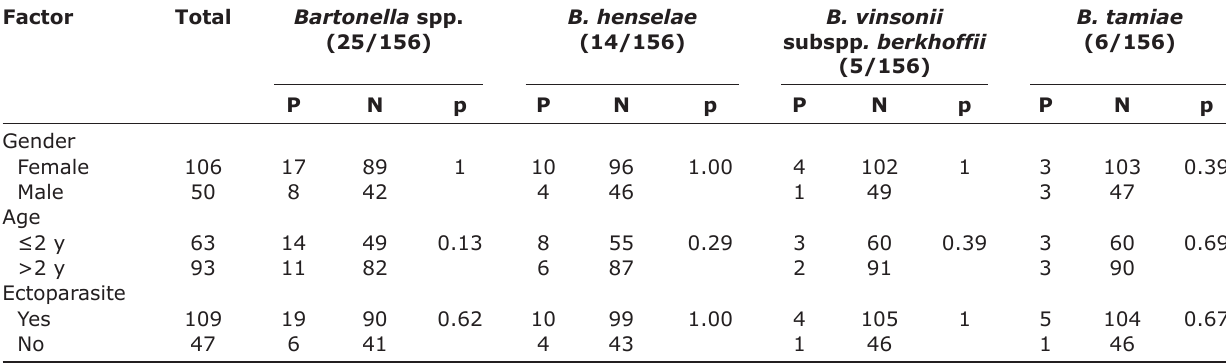
Table-2: Statistical association between the seroprevalence of antibodies against B. henselae, B. vinsonii subspp. berkhoffii, B. tamiae, and different factors (univariate analysis). Factor